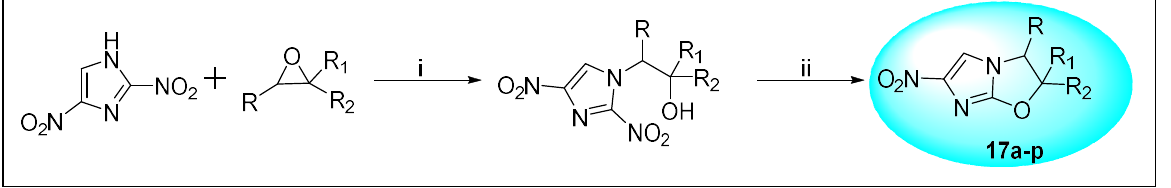
Table 4. In vitro and in vivo Anti-tubercular activity.